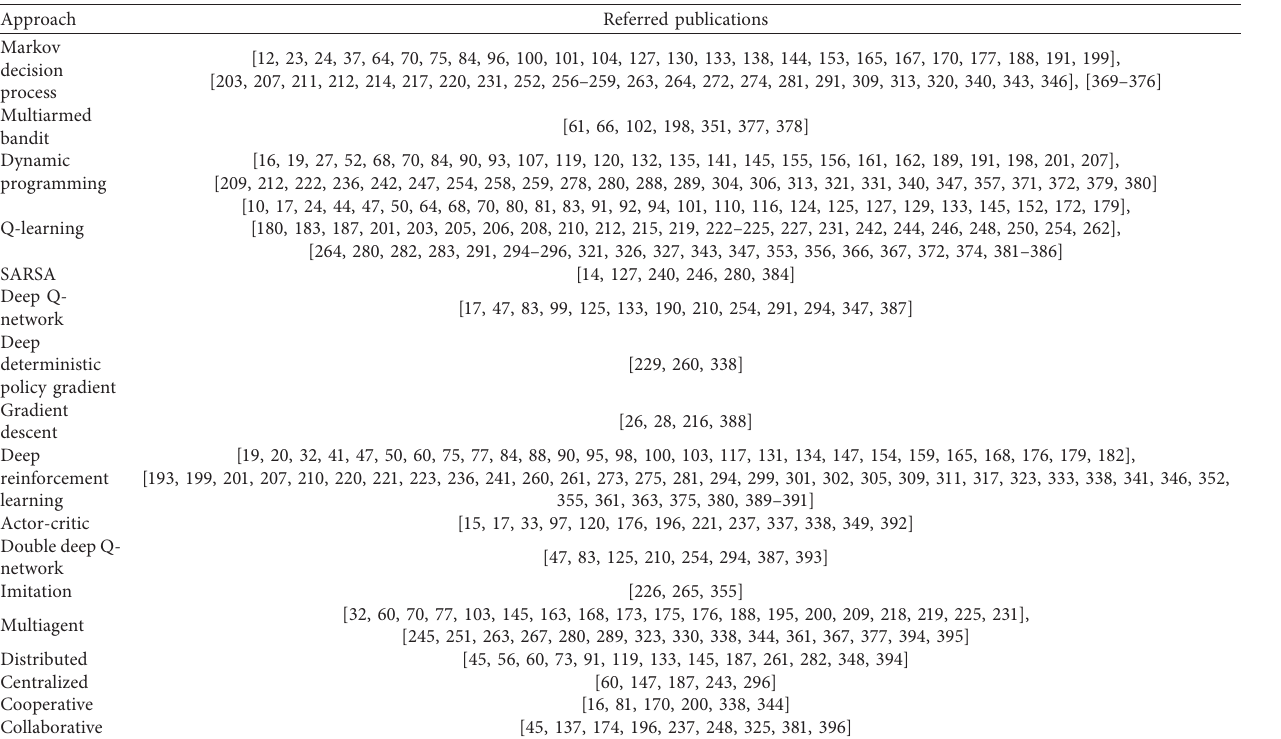
Table 5: Publication reference by methodological approaches.